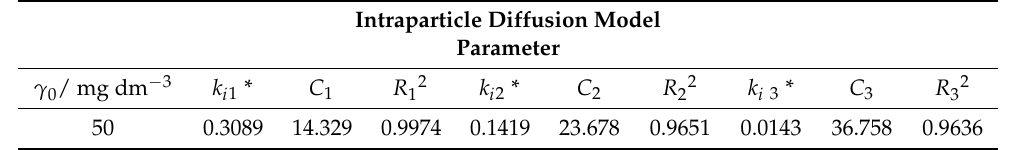
Table 4. Parameters of the Weber and Morris intraparticle diffusion model for the removal of